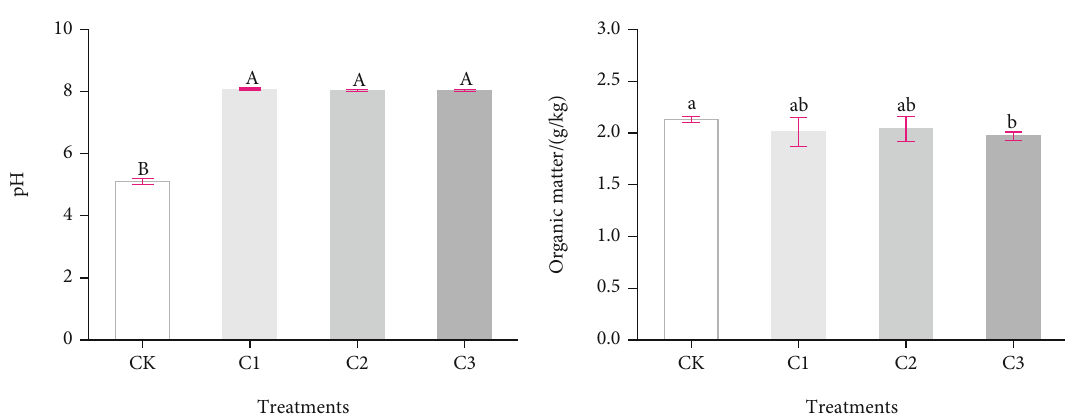
Figure 2: E ff ect of lime combined with fertilizer on soil pH and organic matter of rare earth mine tailings. CK: fertilizer (0.20 gN, 0.30g O , and 0.30g K O per kg of tailings); C1: fertilizer + 10g/kg lime; C2: fertilizer + 25 g/kg lime, and C3: fertilizer + 50 g/kg P 2 5 2